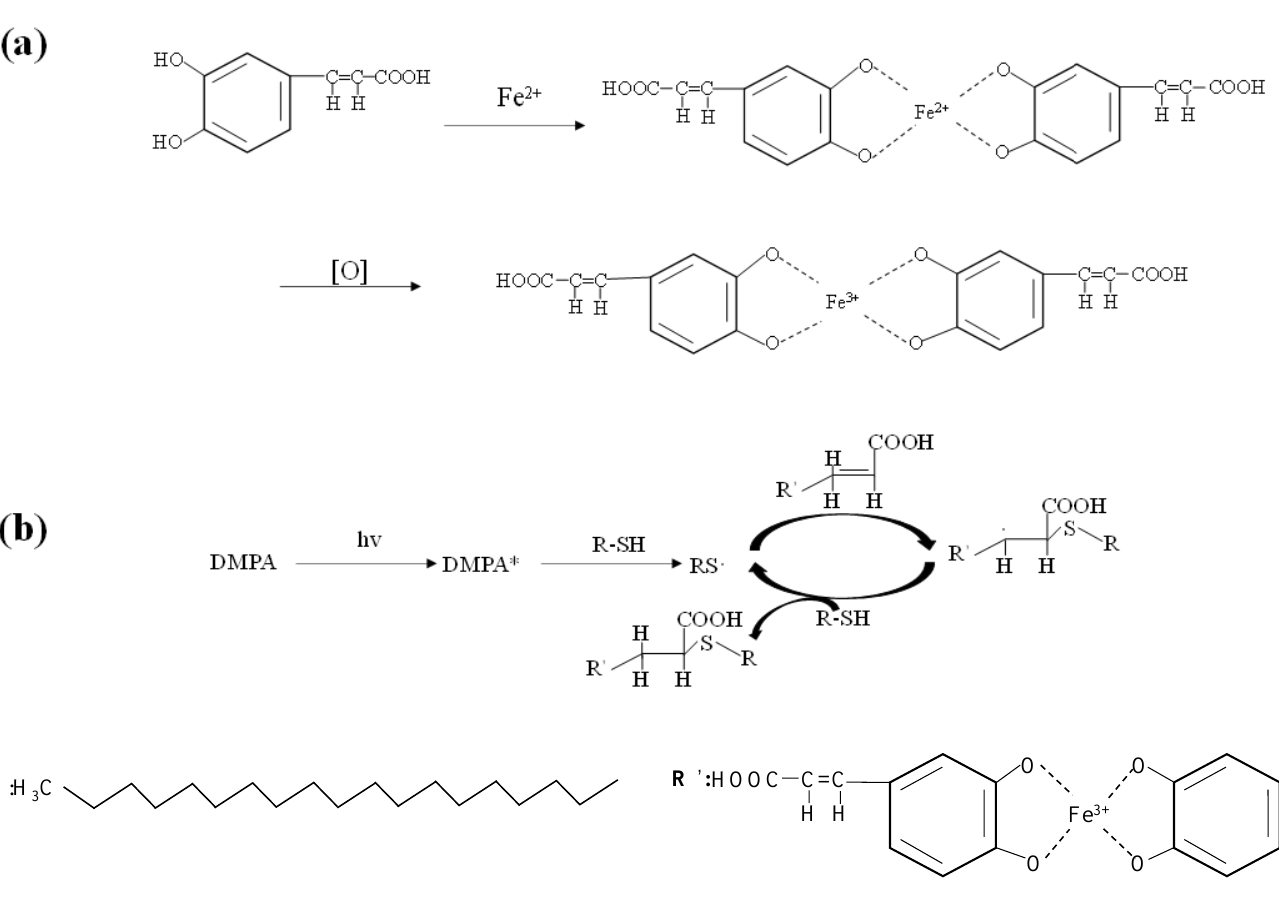
Figure 1. ( a ) Caffeic acid forms chelate with iron ions; ( b ) click chemical reaction of chelate with n-octadecyl mercaptan. (* is the state in which the photoinitiator splits into free radicals)